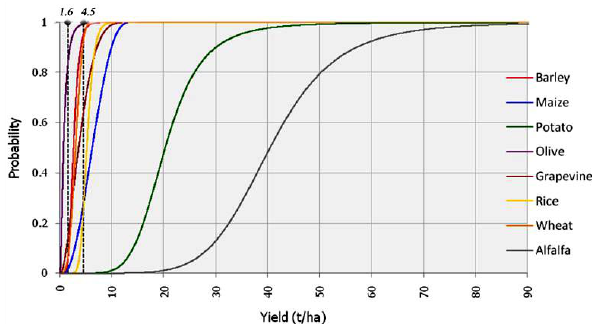
Fig. 5. Cummulative density probability function of crop yield.